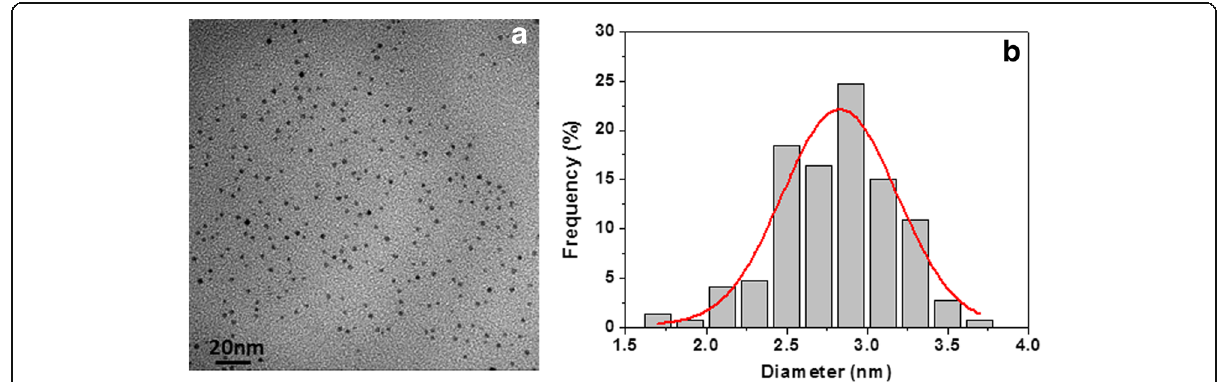
Fig. 1 TEM micrograph of nano-Pd/PVP sample ( a ) and particle size distribution ( b